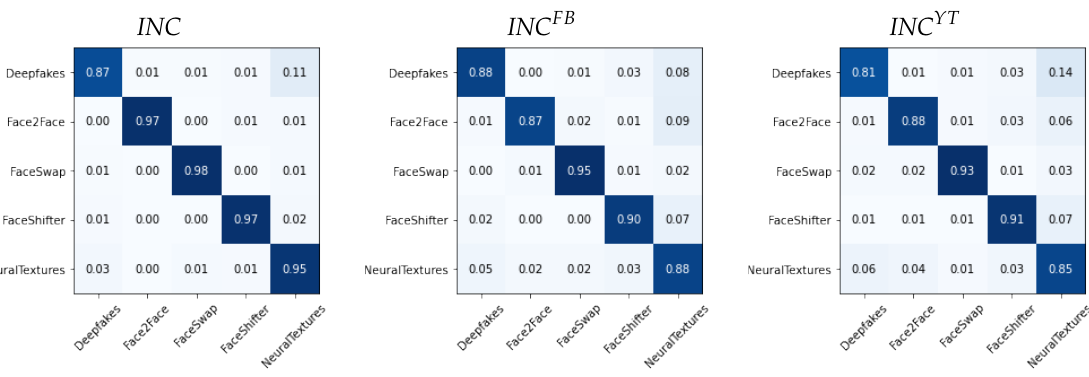
Figure 7. Confusion matrices obtained from INC ( x ) in the pre-social and post-social scenarios.